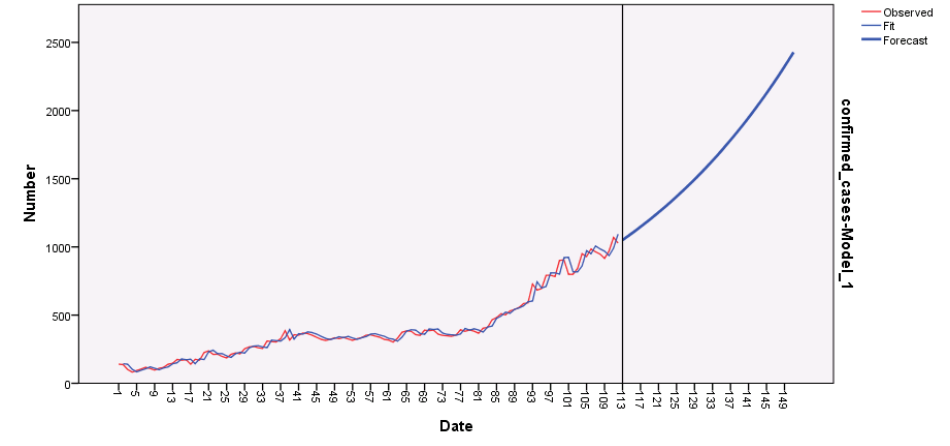
Figure 7. Predicting daily COVID-19 confirmed cases with 95% confidence intervals (CIs) in Saudi Arabia for the period from 23 April 2021 to 31 May 2021.